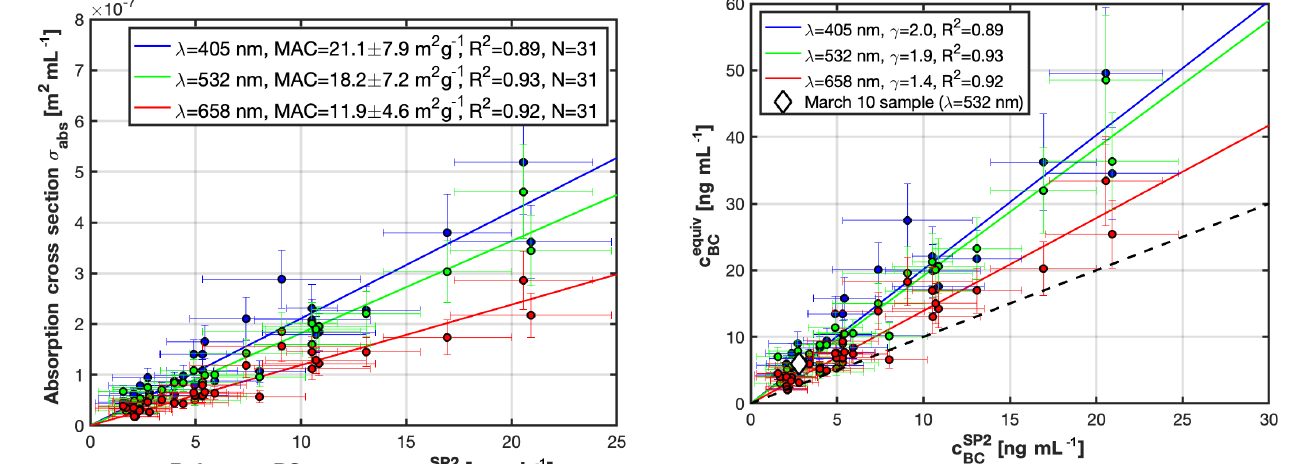
Figure 7. Snow mass-specific absorption cross section σ abs of the snow samples (Eq. 1) as a function of the mass concentration c SP2 deduced from the SP2 measurements. The BC mass-specific ab- sorption cross section, MAC, is deduced from a linear regression without intercept of the data per wavelength and is given in the leg- end. See text for details.